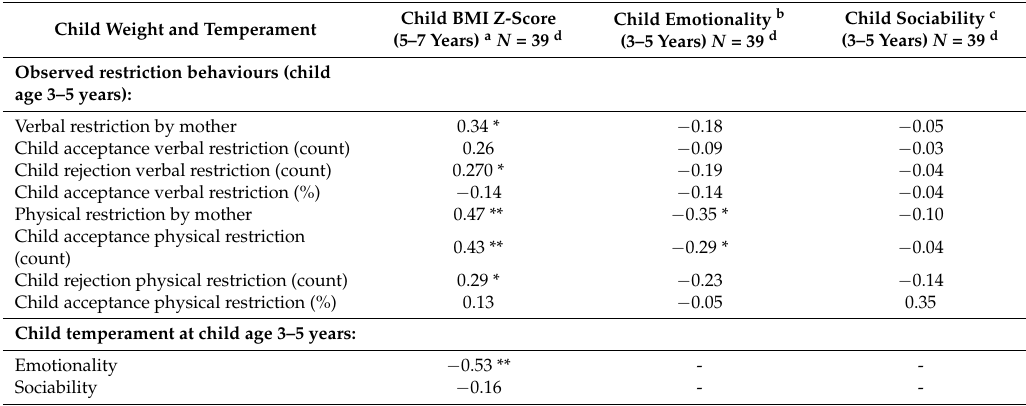
Table 2. Correlations between observations of restrictive feeding and child temperament at 3–5 years with child BMI Z-scores at 5–7